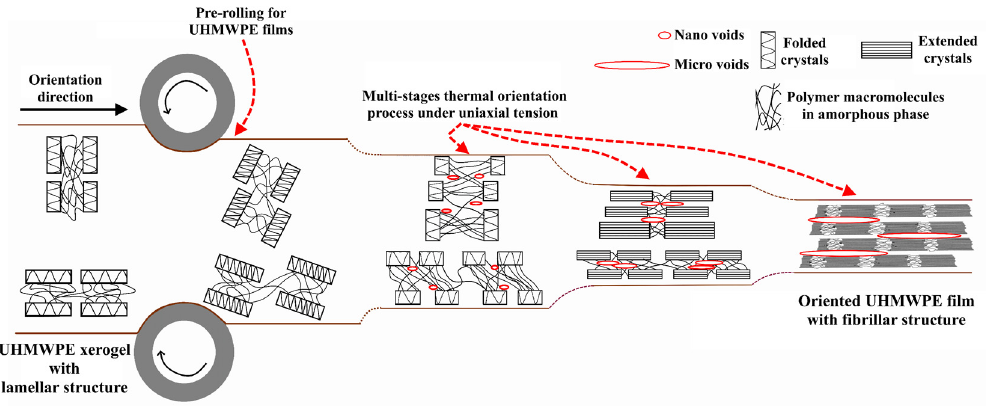
Figure 2. Proposed diagram that illustrates the preparation stages of the oriented UHMWPE films using the thermal orientation hardening